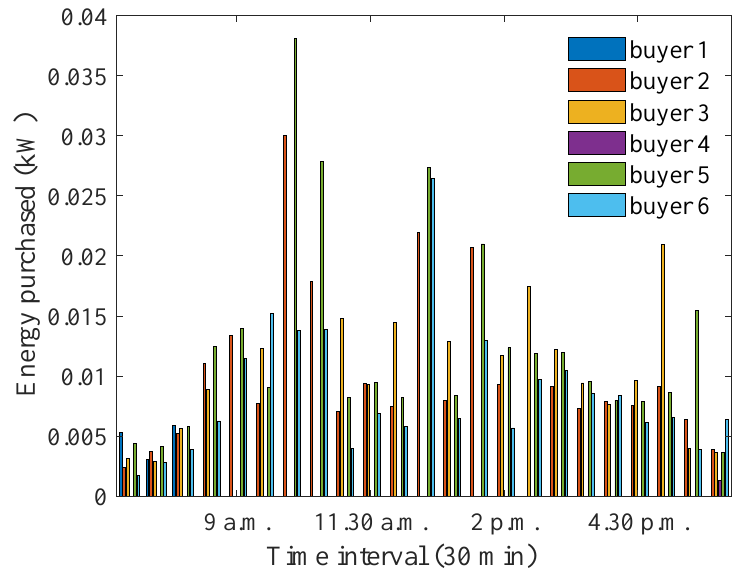
Figure 29. Optimum energy purchased when profit threshold is increased to a larger value.